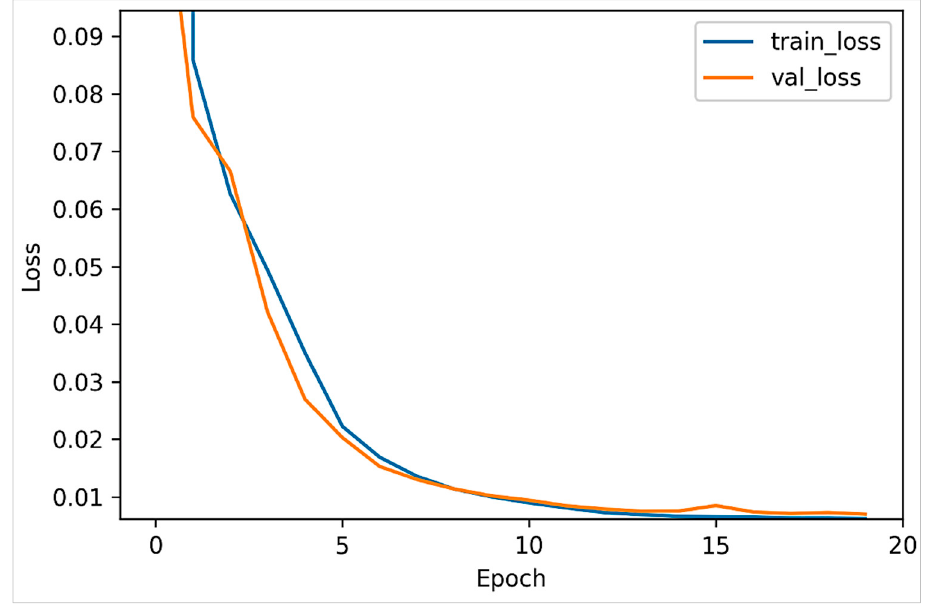
Figure 7. VAE loss in training and validation sets (TD set).